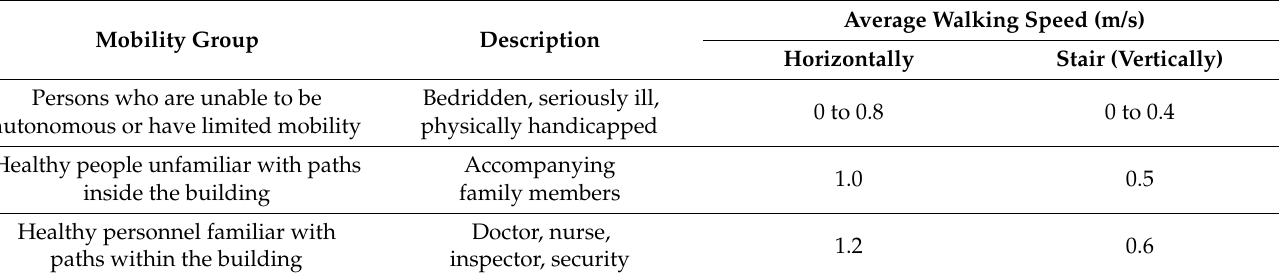
Table 4. Mobility of personnel in a care